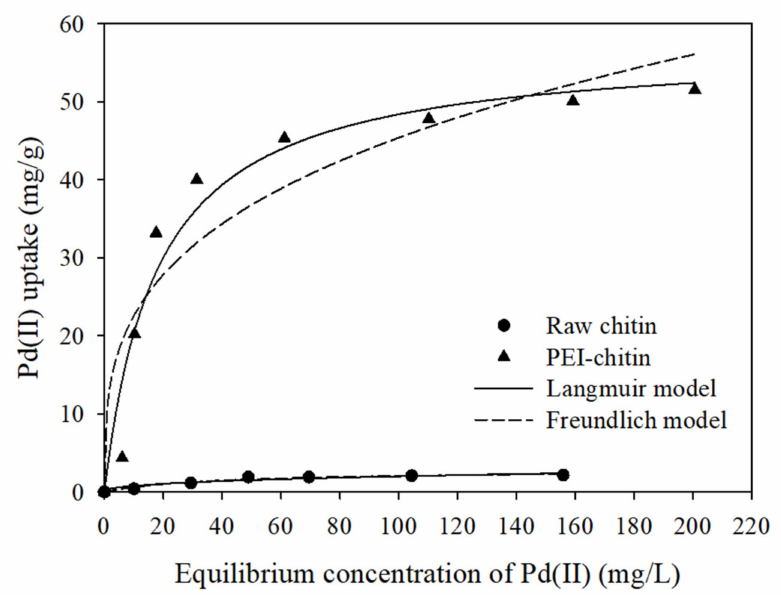
Figure 3. The adsorption isotherms of raw chitin and PEI-chitin for Pd(II) fitted by Langmuir and Freundlich models. Table 3. Isotherm parameters of Pd(II) adsorption onto raw chitin and PEI-chitin. Langmuir Model Freundlich Sample q exp (mg/g)